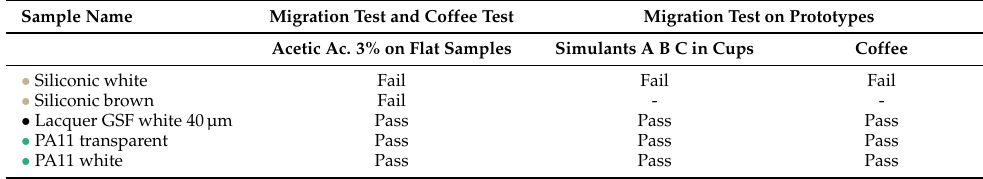
Table 3. Results of the migration tests for the more promising